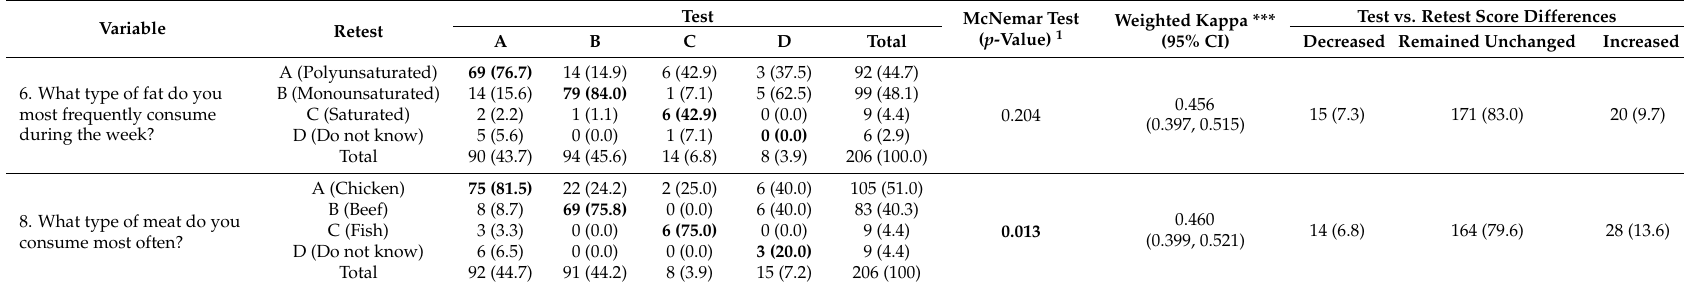
Table 7. Agreement between both Mini-ECCA questions (fats and meats) with four response options ( n =